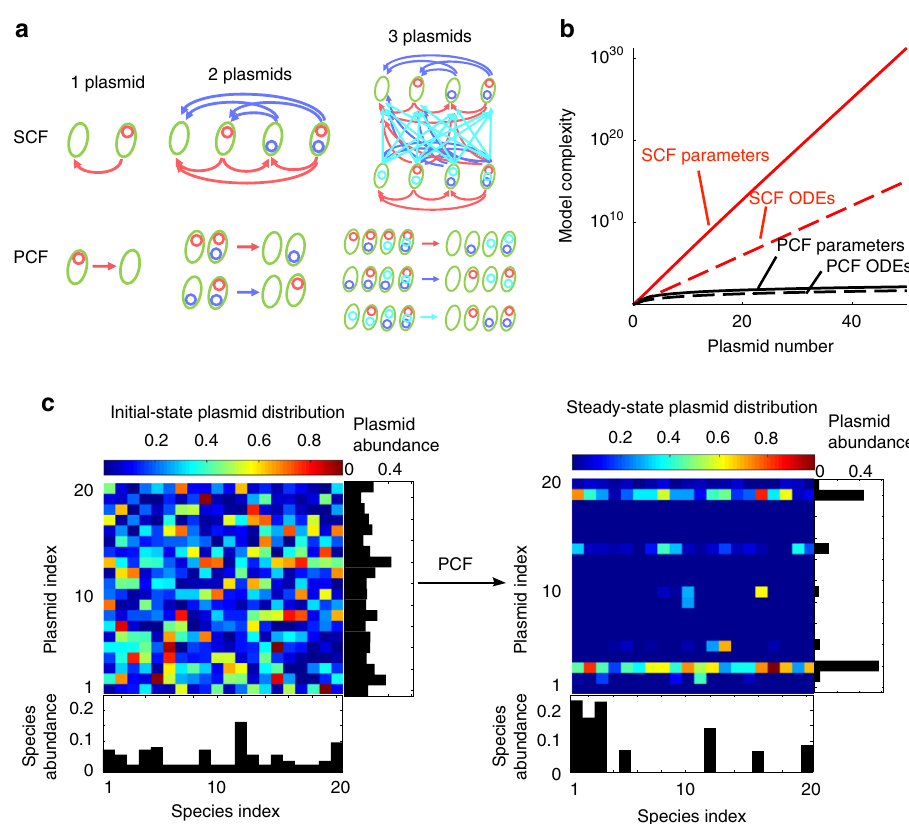
Fig. 1 A plasmid-centric framework (PCF) to model horizontal gene transfer in microbial communities. a Comparison between the subpopulation-centric framework (SCF) and PCF for one species transferring 1 – 3 plasmids. The arrows represent the plasmid transfer from the donor to the recipient. b Model complexity of single-species communities as a function of the number of plasmids. The model complexity refers to the number of ordinary differential equations (ODEs) or the number of parameters required in each model. c Simulation of the dynamics of a community consisting of 20 species transferring 20 plasmids. Different species or plasmids are distinguished by the indices. A random set of parameter values were used. The initial distributions (left) of population sizes and plasmid abundances were also random. The right panel shows the steady-state distributions of the plasmids across different species, quanti fi ed as the relative abundance of plasmids in each species. The relative abundance of plasmid j in species i was calculated as the fraction of species i cells that contains plasmid j relative to the total number of species i cells. The total abundances of each species and each plasmid in the entire community are shown as